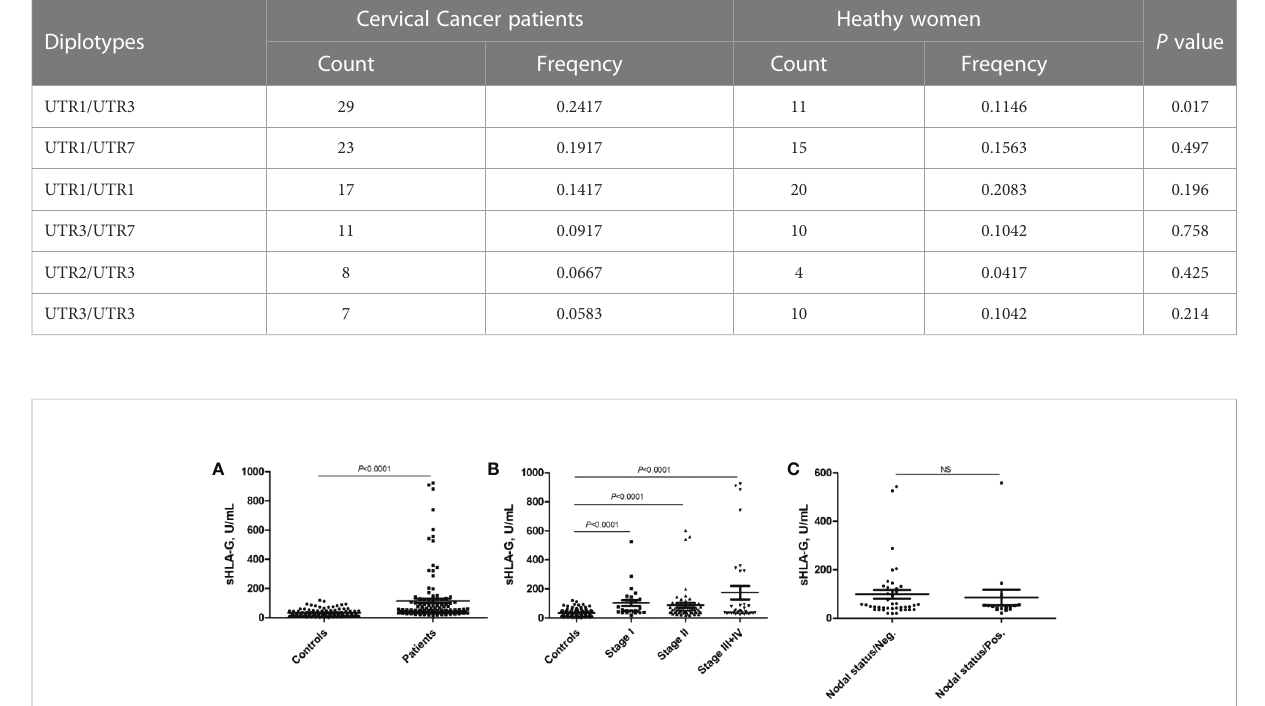
FIGURE 2 Comparison of sHLA-G plasma levels of cervical cancer patients and healthy women. (A) sHLA-G is signi fi cantly ( P <0.0001) elevated in patients, (B) sHLA-G levels increase with ascending FIGO stage in patients without reaching signi fi cance. (C) sHLA-G levels based on nodal status. Bars indicate mean ± SEM. Statistic was performed by Mann-Whitney test. NS, not signi fi cant.